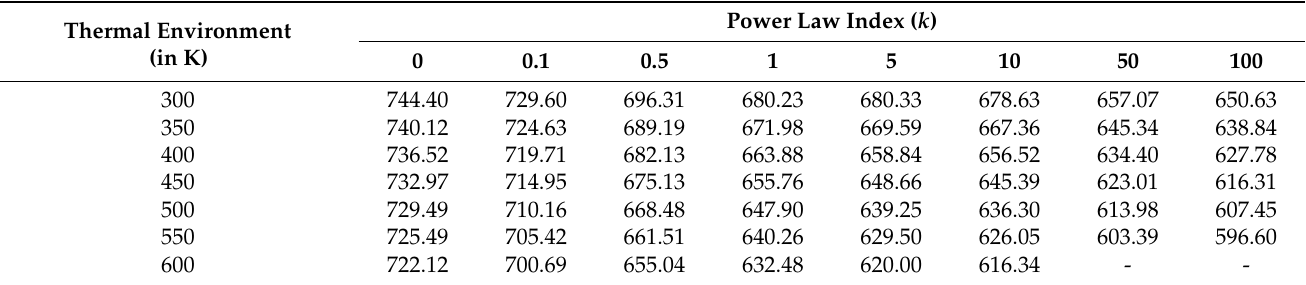
Table 8. Effect of a uniform thermal field on critical buckling temperatures (in K) of a Ti-6Al- 4V/aluminum oxide FGM shell for different material composition in re-entry vehicle nose